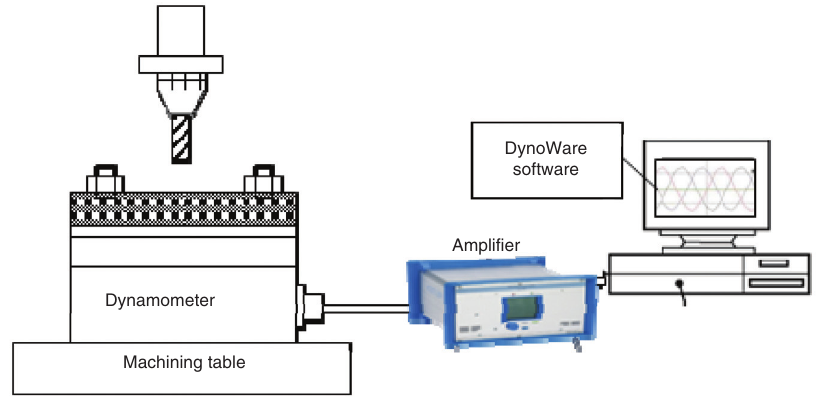
Figure 3 Schematic setup used in CNC vertical machining center.